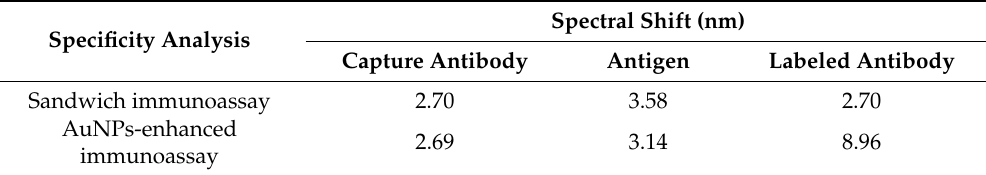
Table 1. Specificity analysis of the fabricated SPR biosensor.